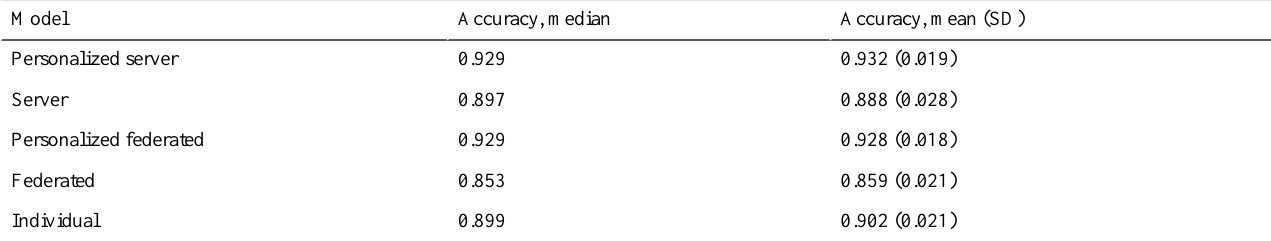
Table 3. Median and mean accuracy of each model over 15